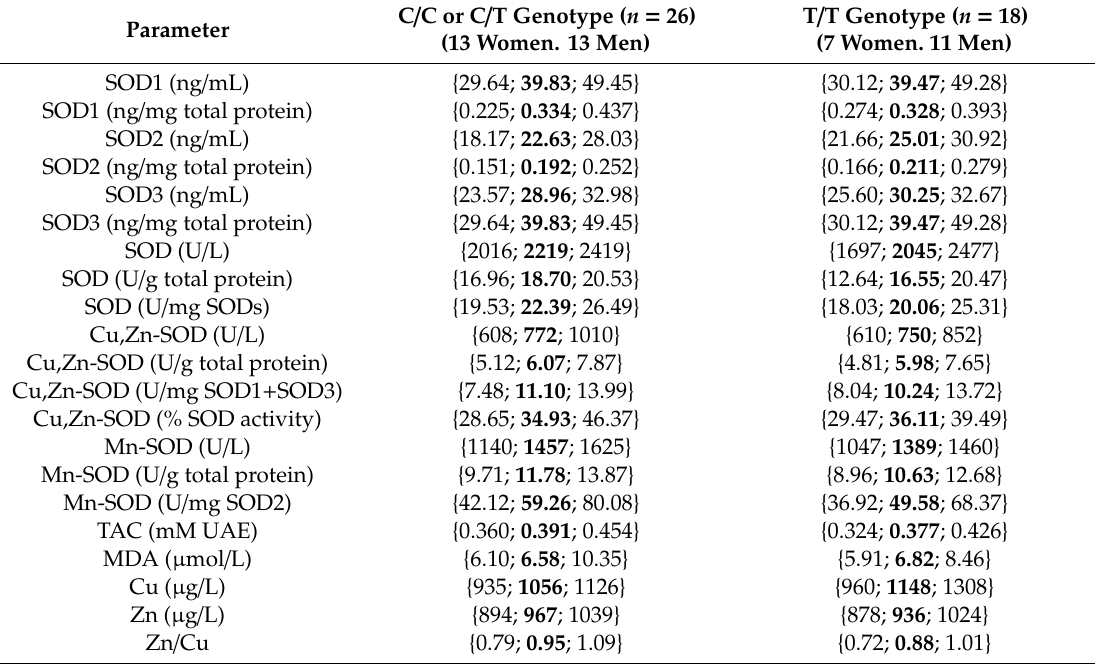
Table A2. Values of selected pro- and antioxidative parameters, and concentration of selected metals, in context of genotypic variability of rs5746105 ( SOD2 ), in obese